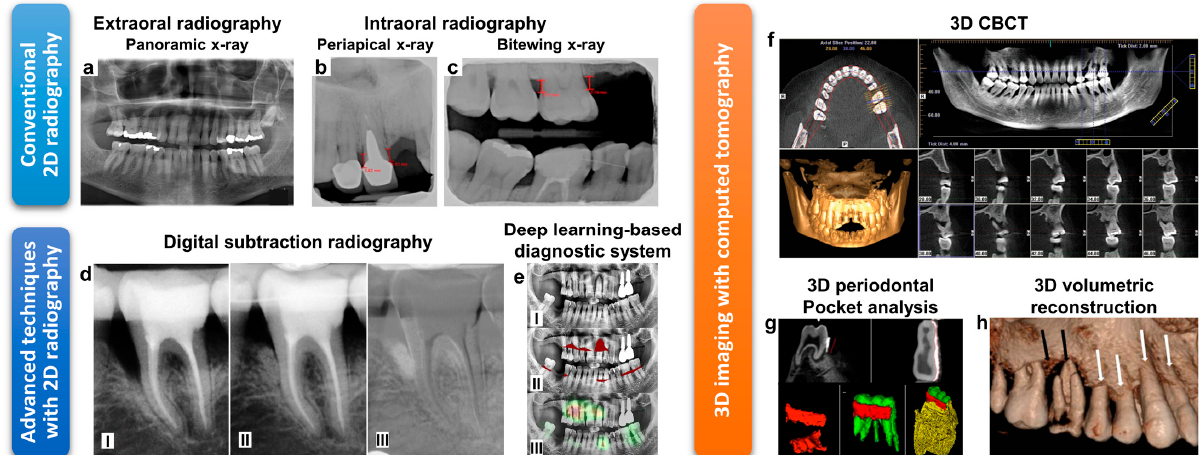
Figure 2. ( a – c ) Conventional 2D radiography. ( a ) Panoramic X-ray for capturing the entire mouth with an overall view. Reprinted with permission from [84]. ( b ) Periapical X-ray and ( c ) bitewing X-ray for evaluation of periodontal disease. Reprinted with permission from [85]. ( d ) Digital subtraction radiography for bone-regeneration assessment; (I) baseline radiograph, (II) after 12-month radiograph, and (III) subtraction of (II) from (I). Reprinted with permission from [86]. ( e ) Deep learning-based periodontal bone-loss diagnosis; (I) panoramic radiograph, (II) bone-loss lesion annotated by clinicians, and (III) bone-loss class activation map highlighted by the deep-learning-based system. Reprinted with permission from [87]. ( f ) CBCT software interface including pan-map (top-right), horizontal section (top-left), vertical sections (bottom-right) and 3D reconstructed model (bottom-left). Reprinted with permission from [88]. ( g ) The depth and volumetric measurement of the periodontal pockets using CBCT. Reprinted with permission from [89]. ( h ) 3D volumetric reconstructive CBCT image obtained from a patient with aggressive periodontitis. Reprinted with permission from [90].